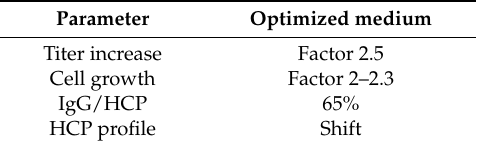
Table 2. Analytical methods used for the characterization of HCP.